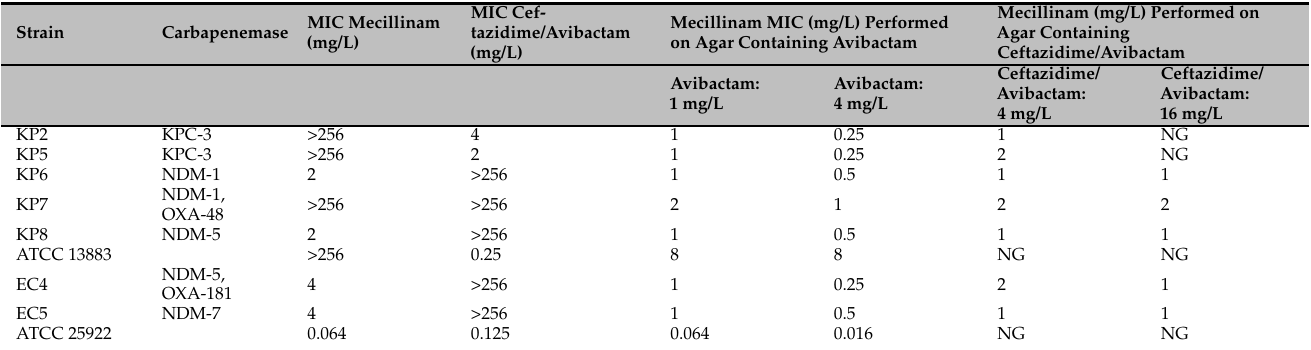
Table 2. Results of synergistic tests of mecillinam combined with ceftazidime/avibactam or avibactam. We showed the isolates chosen for further analyses based on results from Table